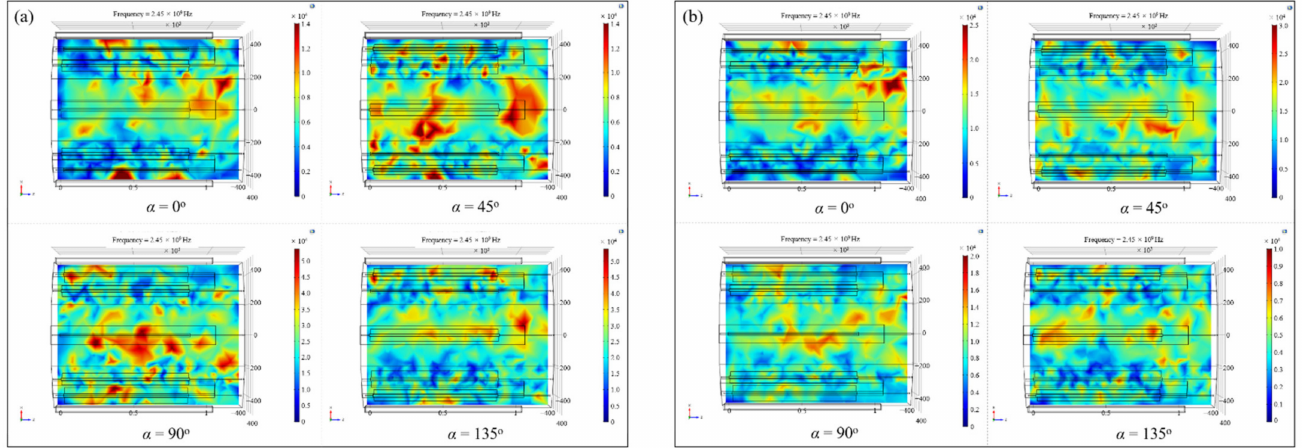
Figure 10. Electric field nephograms on the loading platform during the rotation of mode stirrers under two types of working conditions: ( a ) number (6); ( b ) number